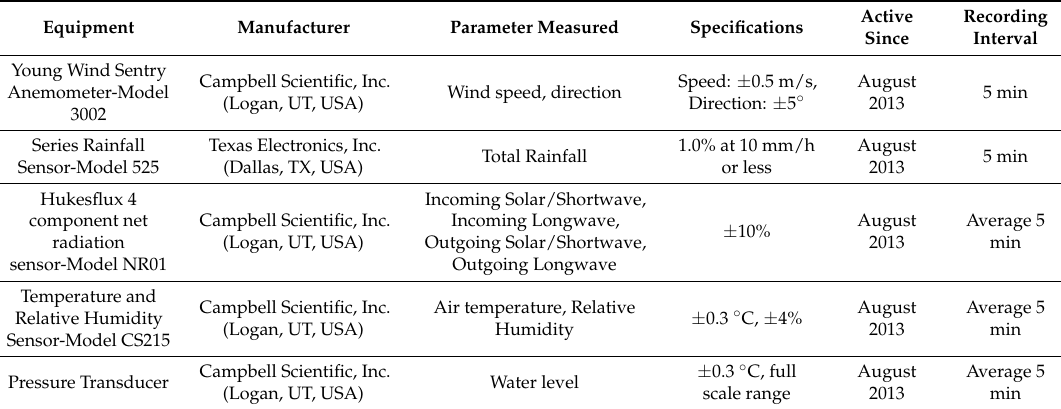
Table 1. Weather station equipment and